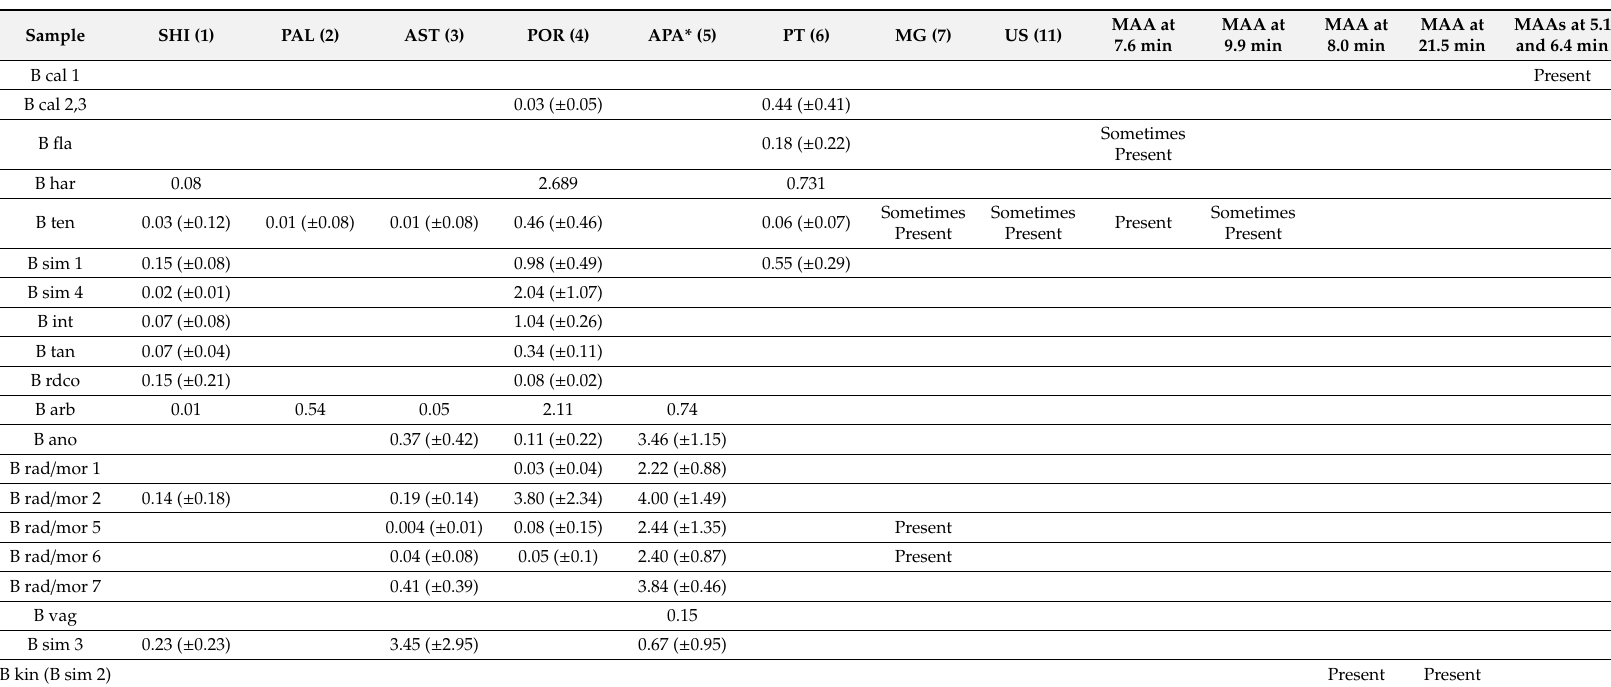
Table 2. Overview of the MAA pattern in the investigated Bostrychia spp., mean values expressed as mg per g of dry material and standard deviation is reported in parenthesis. (detailed results can be found in supplementary material, Tables S1 and S2), assignment of compounds: SHI, Shinorine ( 1 ); PAL, Palythine ( 2 ); AST, Asterina-330 ( 3 ); POR, Porphyra-334 ( 4 ); APA, Aplysiapalythine A ( 5 ); PT, Palythine-Threonine ( 6 ); MG, Mycosporine-Glycine ( 7 ) and US, Usujirene ( 11 ). Assignment of the species: B sim, B . simpliciuscula ; B kin, B . kingii ; B rad, B . radicans ; B ano, B . anomala ; B mor, B . moritziana ; B arb, B . arbuscula ; B int, B . intricata ; B tan, B . tangatensis